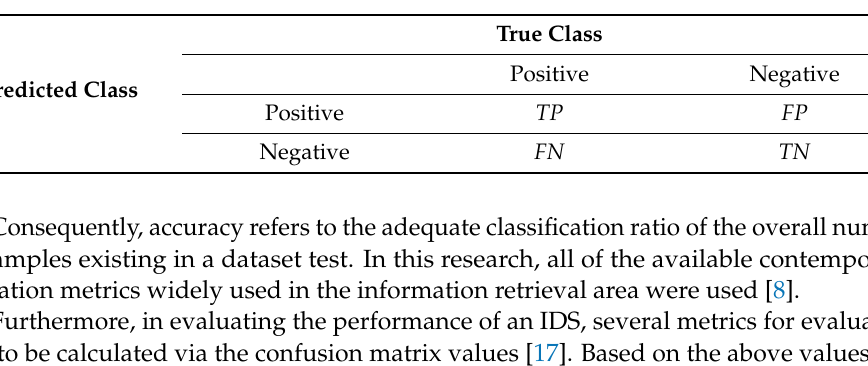
Table 8. The confusion matrix for a binary